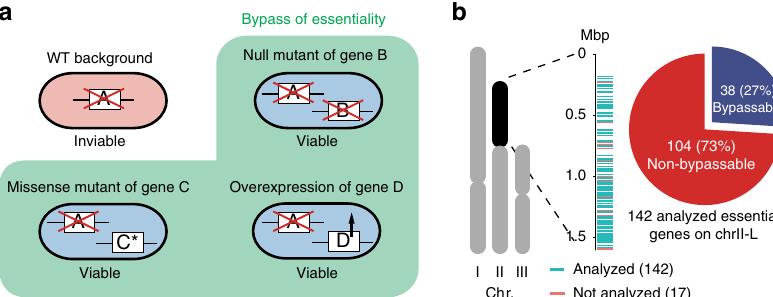
Fig. 1 Systematic BOE analysis. a Three types of monogenic changes that can cause bypass of essentiality (BOE). In the wild-type (WT) background, gene A is essential. BOE may occur when another gene is deleted, mutated, or overexpressed. b Systematic BOE analysis for 89% (142/159) of the essential genes on chrII-L in fi ssion yeast led to the identi fi cation of BOE suppressors for 27% (38/142) of them; these 38 genes were deemed bypassable. The other 104 genes were deemed